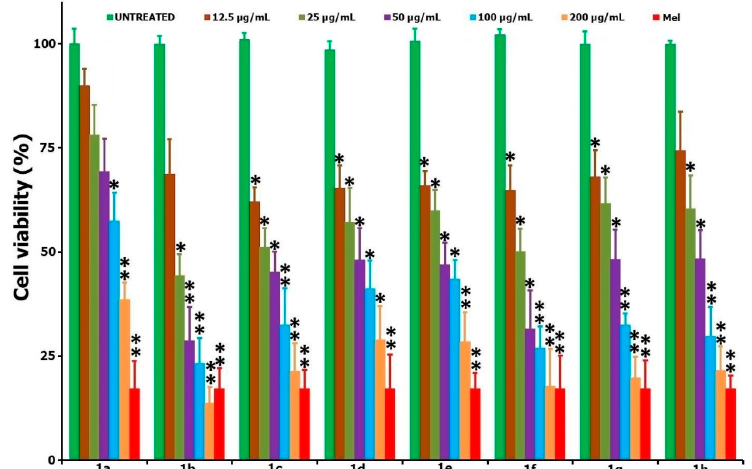
Figure 3. The percentage viability of HepG2 cancer cells, followed by the treatment of synthesized derivatives 1(a – h) in the concentration range of 12.5–200 μ g/mL and compared against the positive control (Mel; 15 μ g/mL) and negative control (no treatment) over a 48 h period. * and ** correspond to significant ( p < 0.05) and highly significant ( p < 0.01) values against the untreated control.